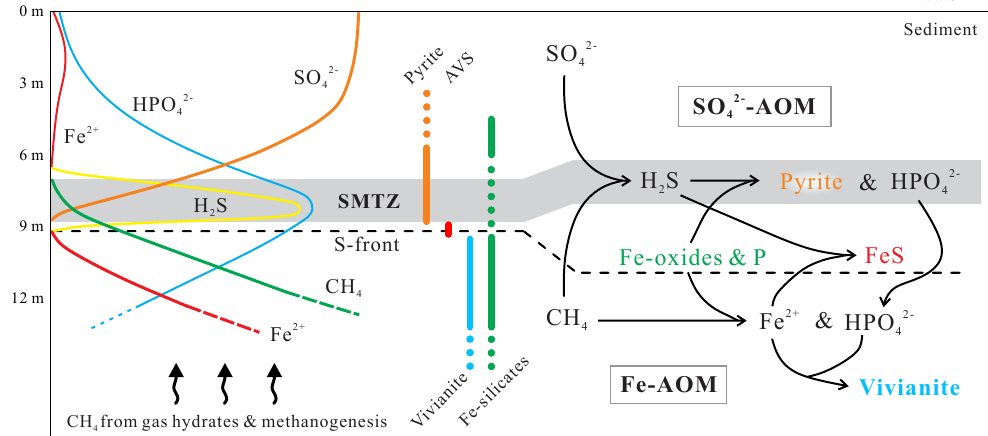
Figure 10. Schematic representation of vivianite formation below the SMTZ at Site 973-4 in the South China Sea. The left and middle parts illustrate idealized porewater and solid-phase mineral distributions. The right part illustrates the interaction between sulfate- and Fe-driven AOM coupling Fe − S − P − CH 4 cycles in proximity to the